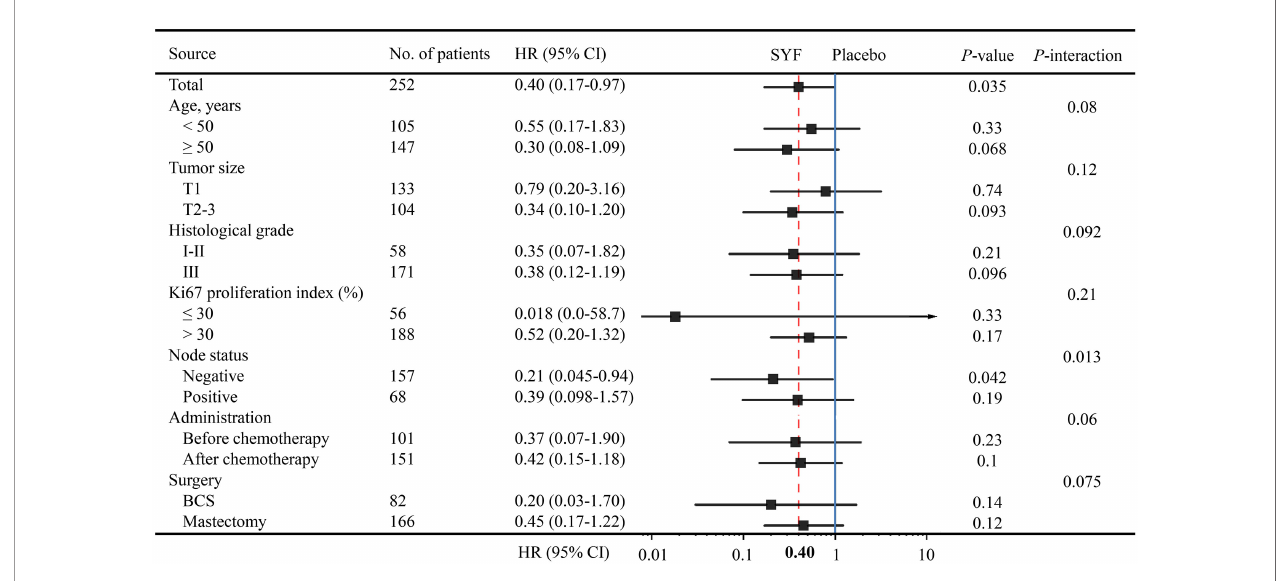
FIGURE 4 | Forest plots of the exploratory subgroup analysis of